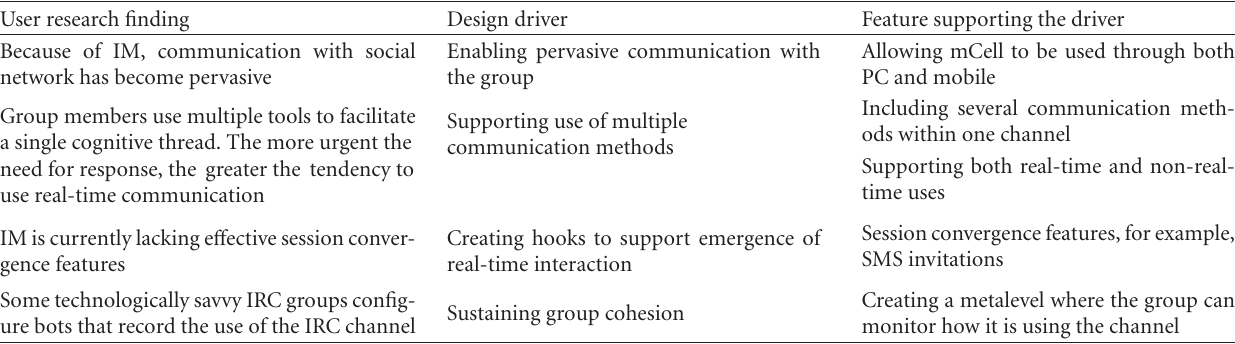
Table 1: User research findings and conducted design drivers and